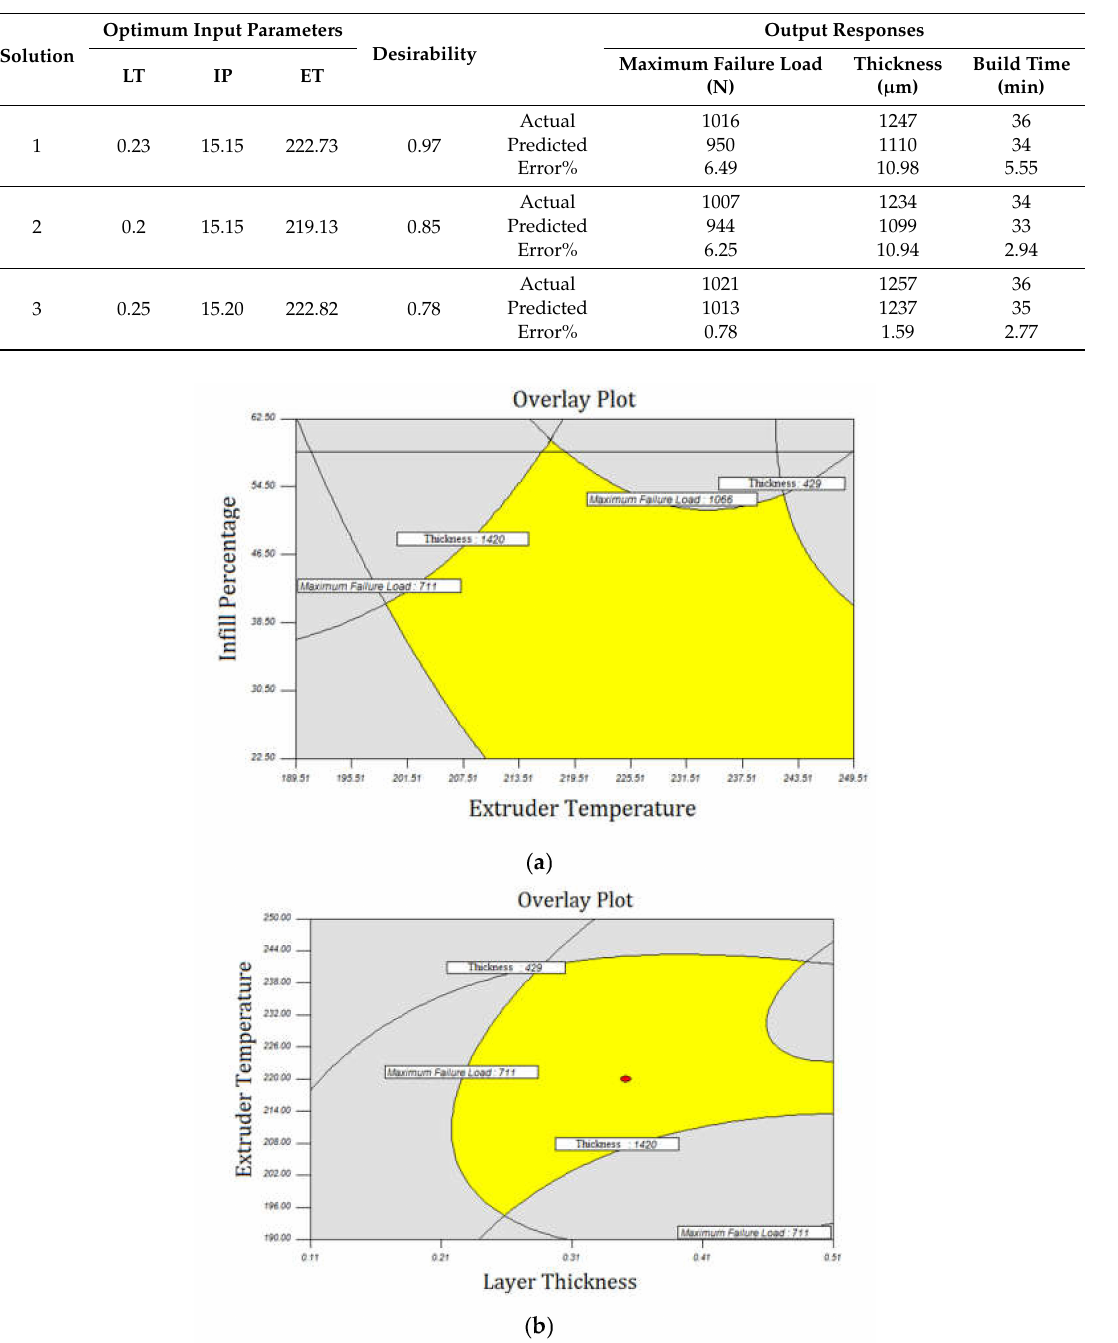
Table 8. Predicted optimum results and experimental validation.